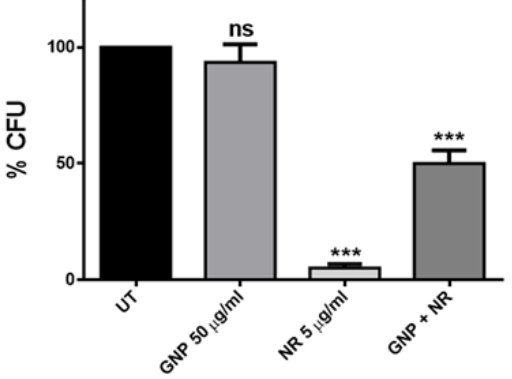
Figure 4. Cell survival after treatment with GNPs, ZnO-NRs, and the combination of both materials. Statistical analysis was performed by one-way analysis of variance (ANOVA) method coupled with the Bonferroni post-test (ns not significant; *** p < 0.001 compared to the